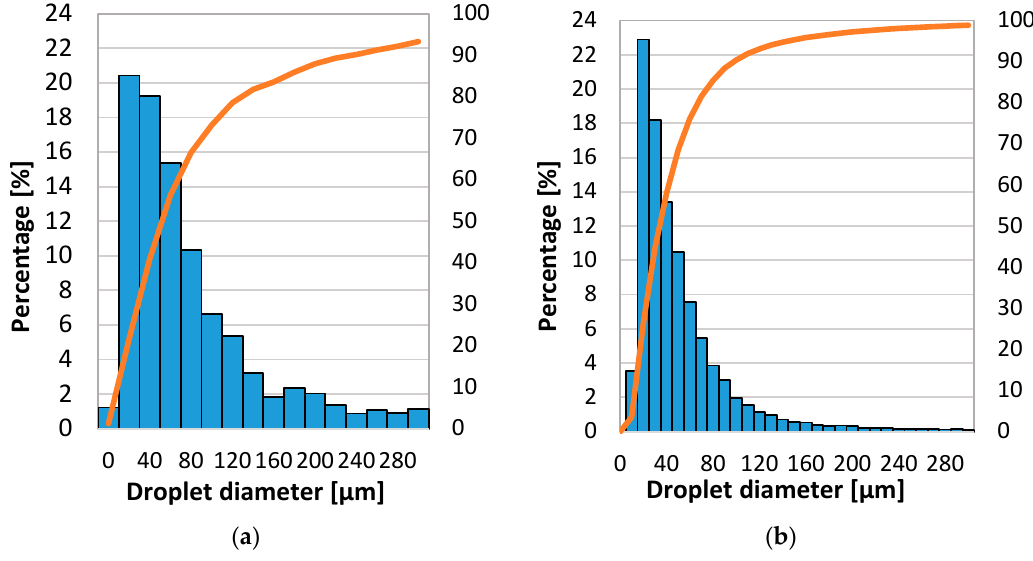
Figure 7. Droplet diameter distribution for experiments E9 and E10, identical nozzle, identical water flowrate, air pressure 1.5 bar left ( a ), air pressure 3.0 bar right ( b ), cumulative percentage orange line.